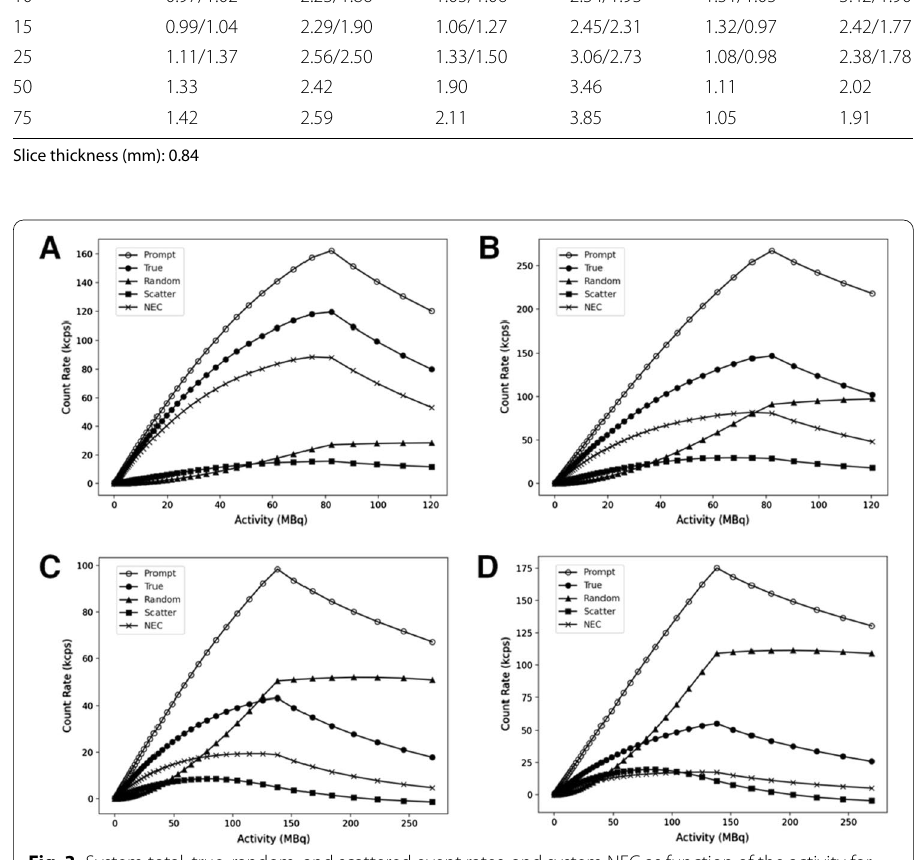
width at tenth maximum obtained with the same algorithm ranged between 1.66 and 4.44.